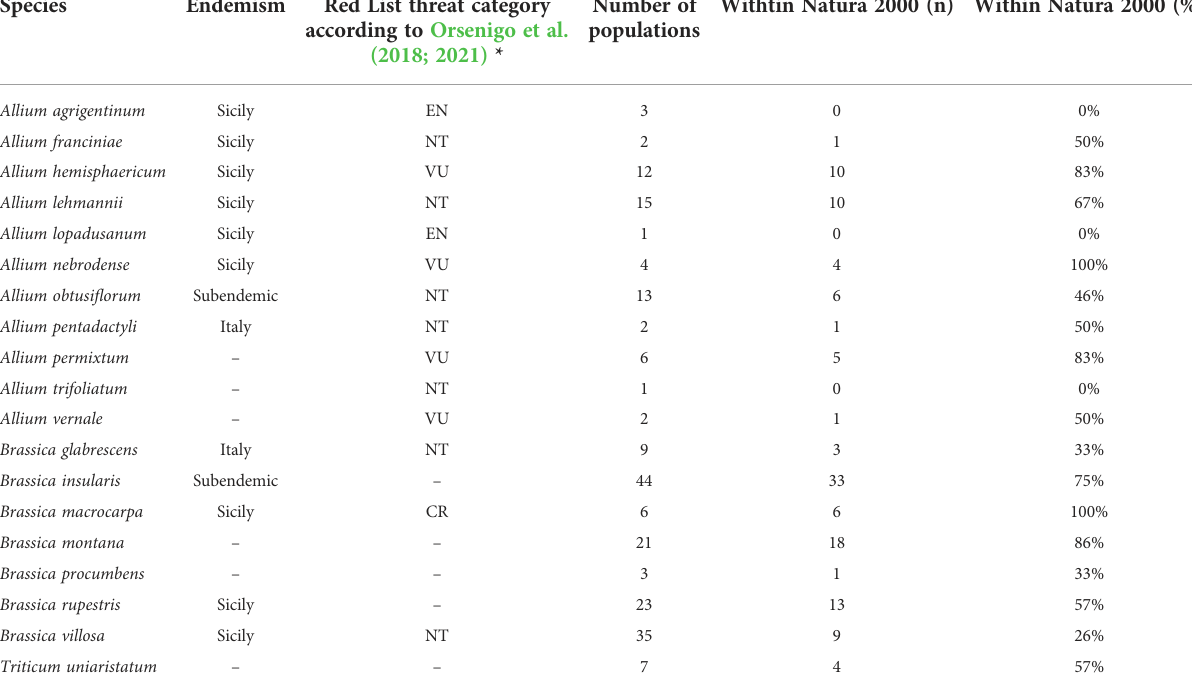
TABLE 3 List of the 19 CWR species with the highest conservation priority ( ‘ A ’ category) belonging to the genera target of this work, and their occurrence in the Italian administrative regions (Ciancaleoni et al.,